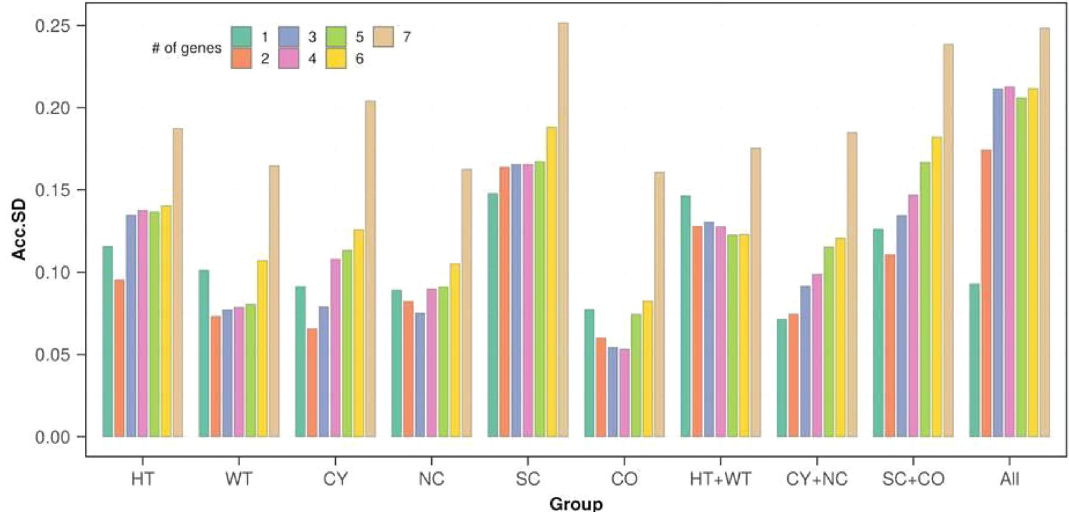
Figure 3. Optimal number of reference genes for each dataset according to GenEx analyses. Accumulated standard deviation (Acc.SD) for the five candidate housekeeping genes in all groups of samples allows estimating the ideal number of genes for normalization. Acc.SD was calculated with the GenEx software package (version 6; http:// www. multid. se). Lower values of Acc.SD indicate the optimal number of reference genes. HT, Pkd1 - haploinsufficient; WT, wild type; CY, cystic; NC, noncystic; SC, severely cystic; CO, control for the severely cystic